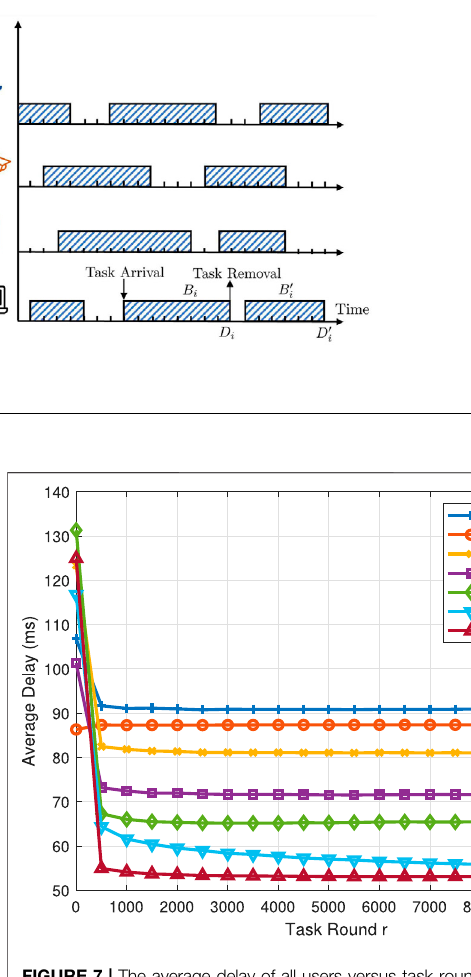
FIGURE 7 | The average delay of all users versus task round r